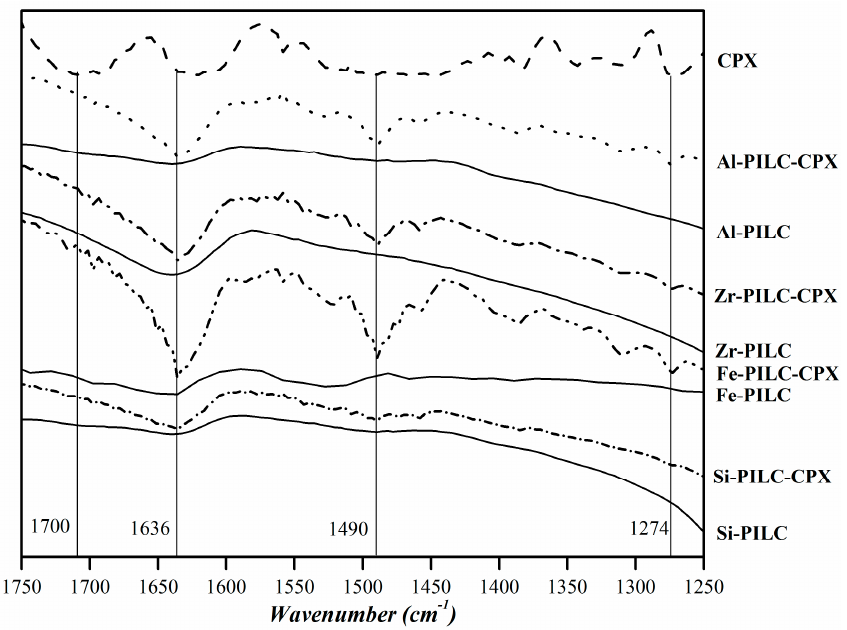
Figure 7. FTIR (Fourier Transform infrared spectroscopy) spectra of CPX, PILC, and the adsorption complexes obtained.